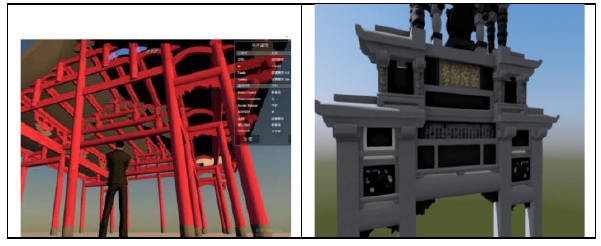
Fig. 5. VR Results of Fuzor Platform Establishment (the left: Tainan Confucian Temple, the right: Qiu Lian-gung's Mother Chastity Arch in